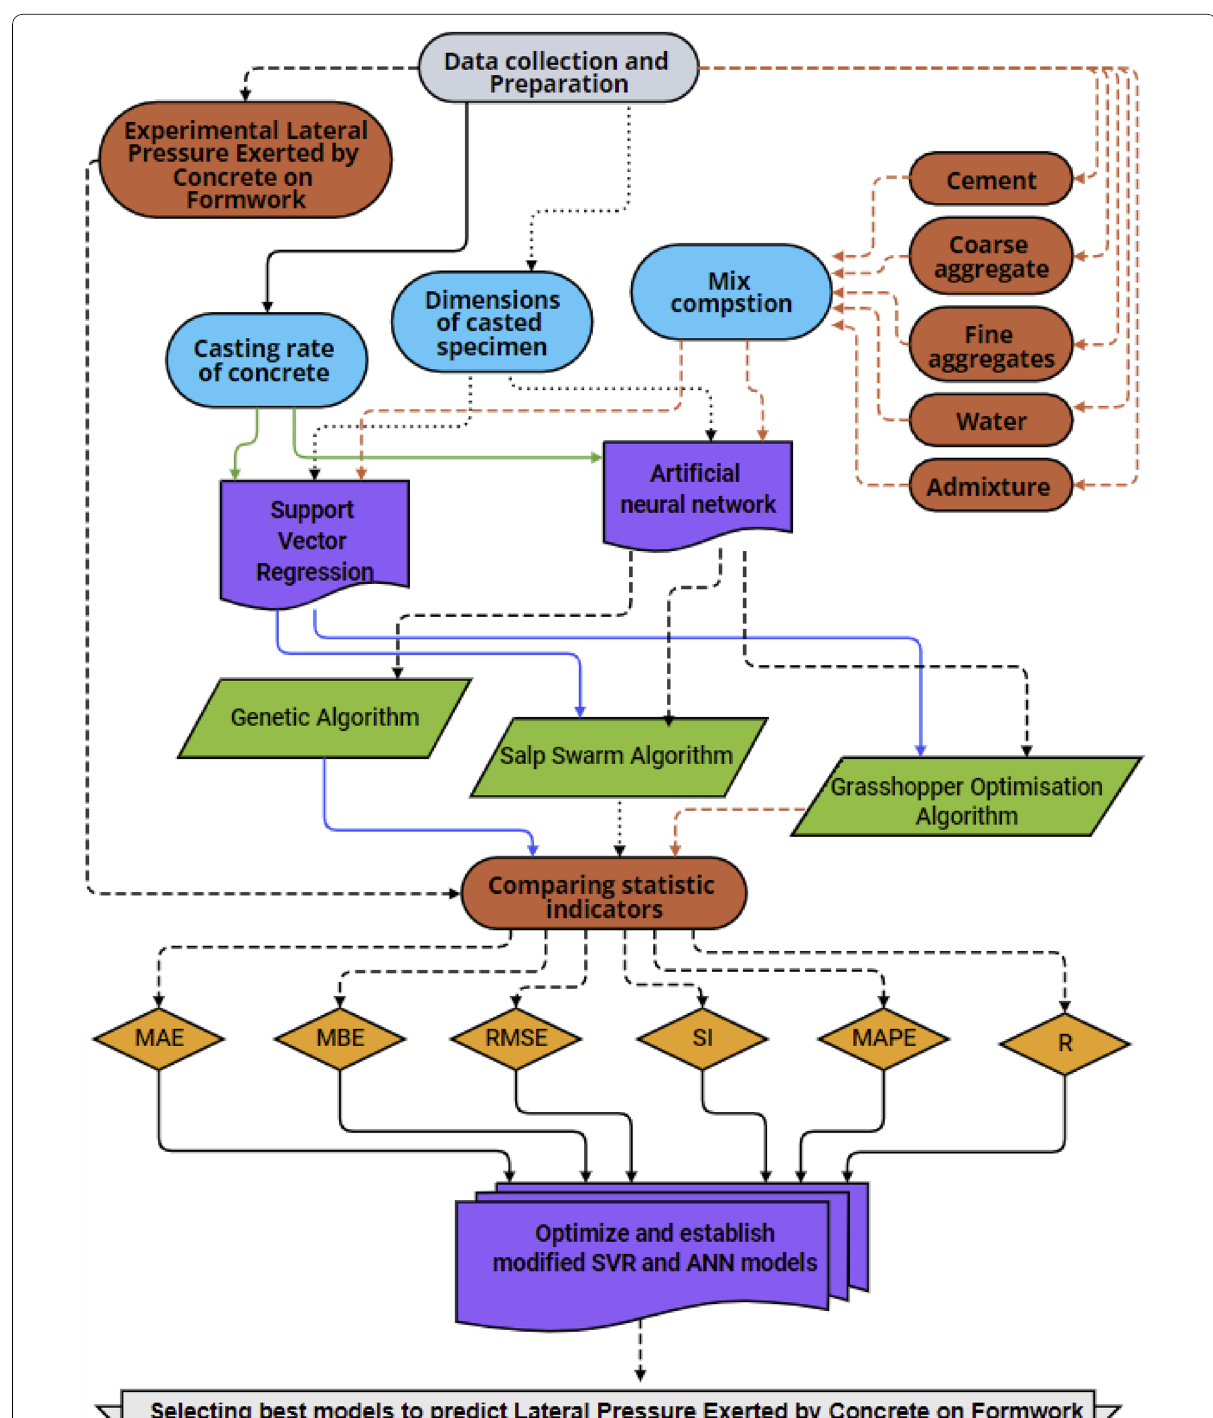
Fig. 1 The flowchart diagram process followed in this